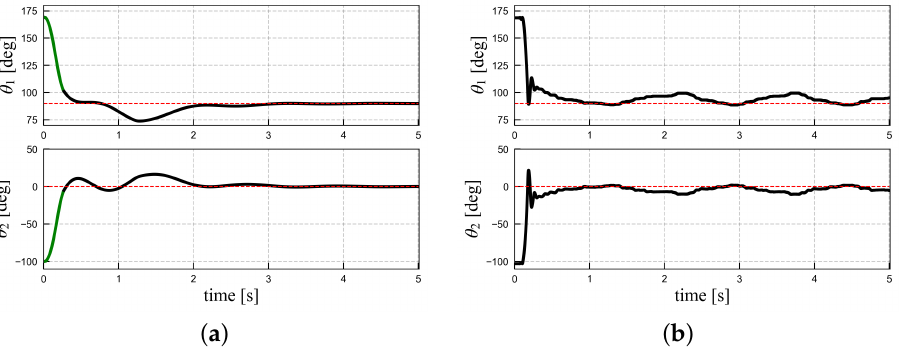
Figure 12. Algorithm 3—Angular positions—( a ) simulation (the green part of the curve indicates when the swing-up controller is active), ( b )